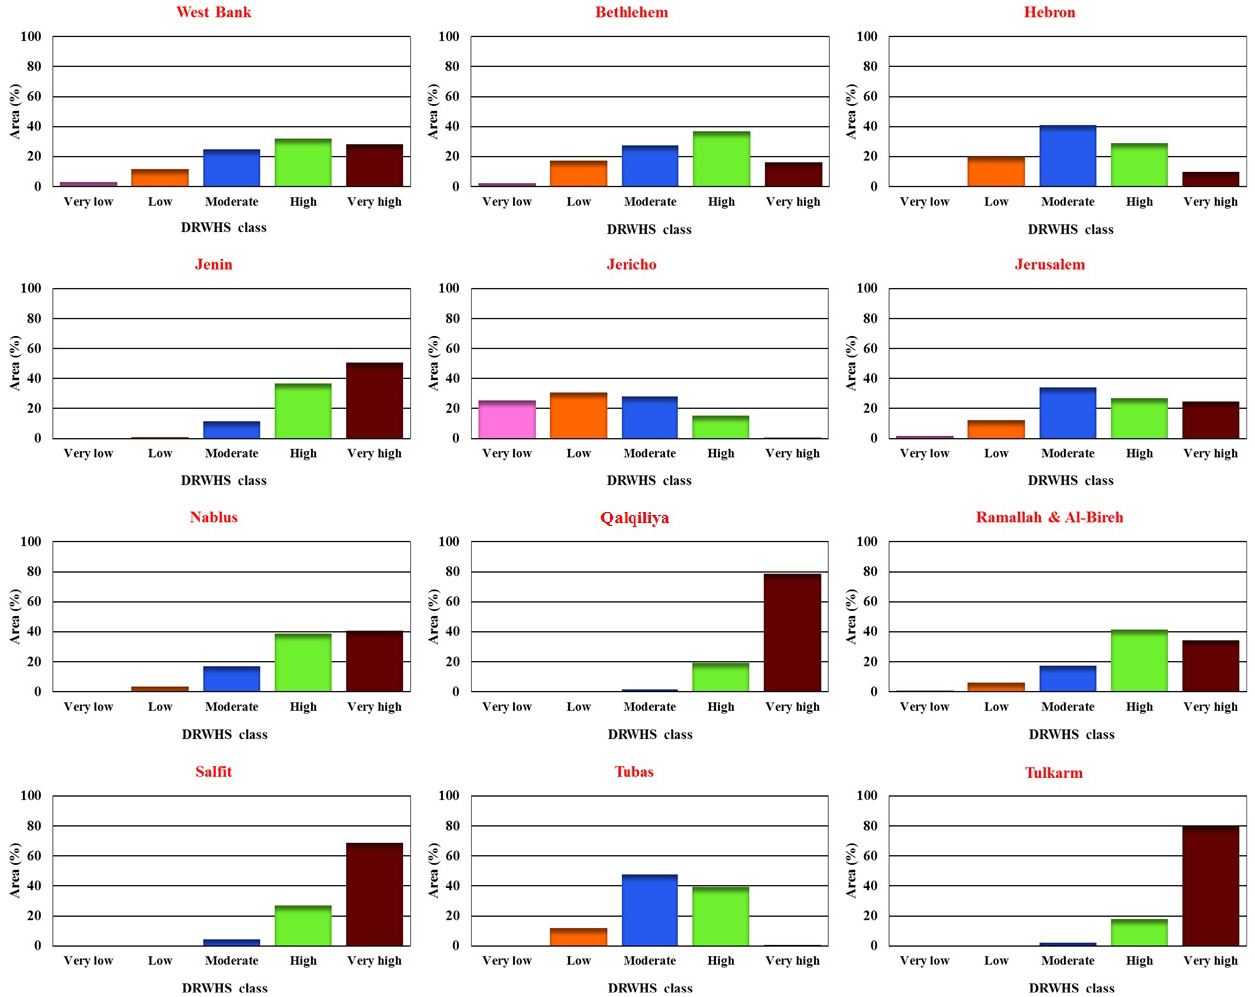
Figure 8. Area percentages of the different DRWHS classes in the different West Bank